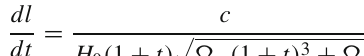
also noteworthy that Case I and Case II are quite